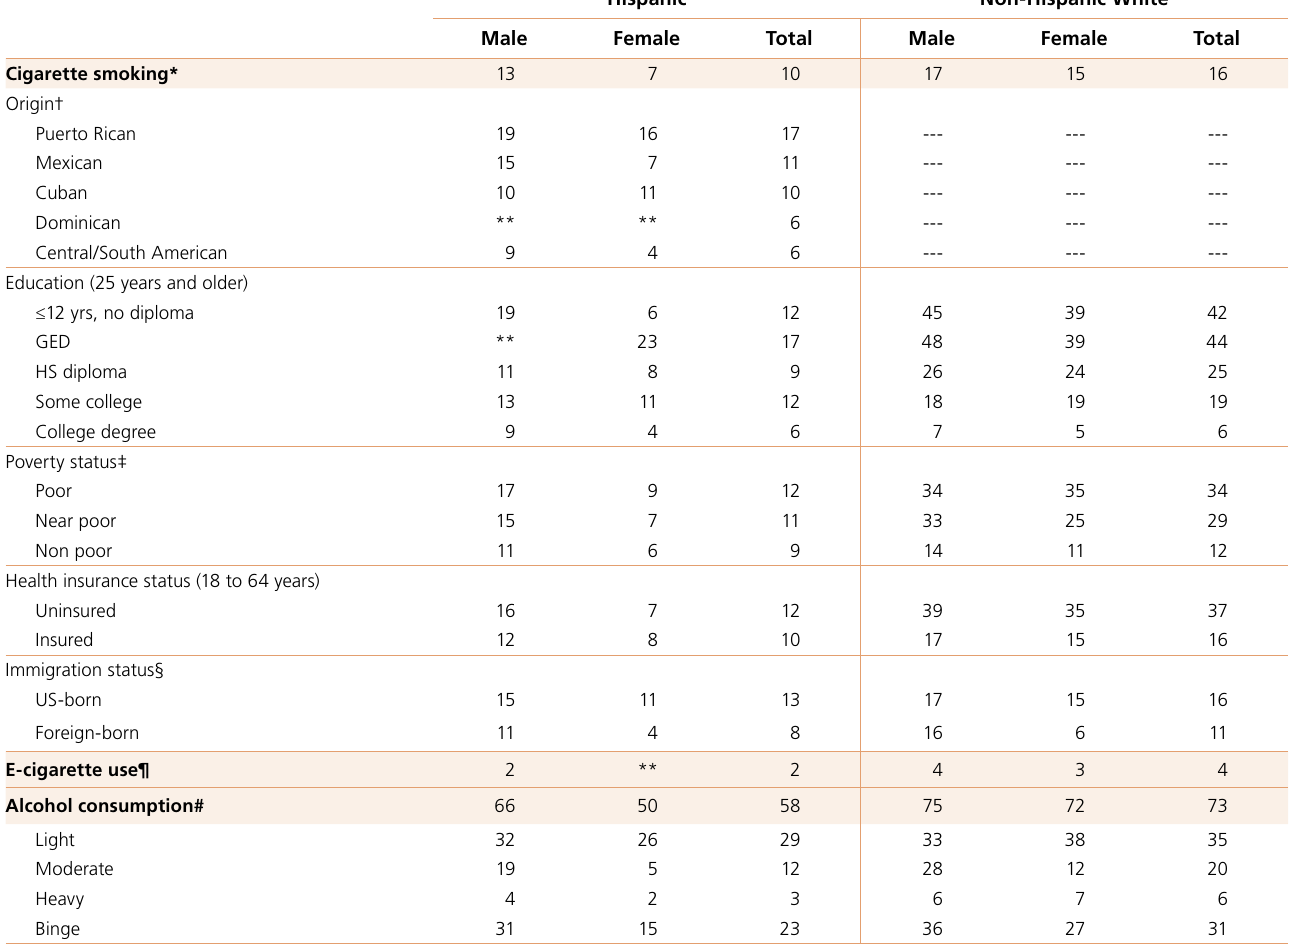
Table 6. Current Cigarette Smoking, Electronic Cigarette Use, and Alcohol Consumption (%), Adults 18 Years and